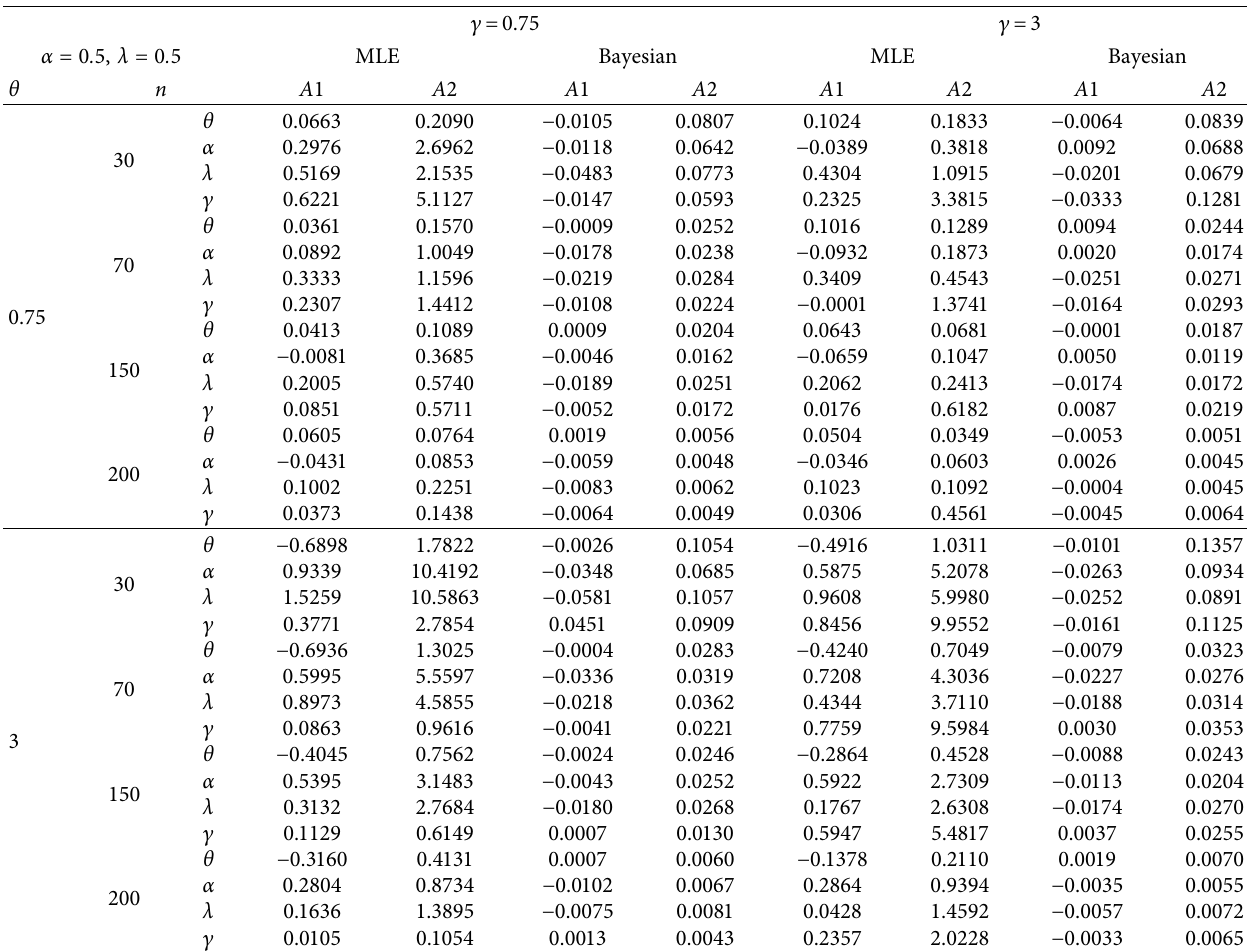
Table 1: A 1 and A 2 of MOEGM parameters by MLE, and Bayesian when. α � 0 . 5 , λ � 0 . 5.